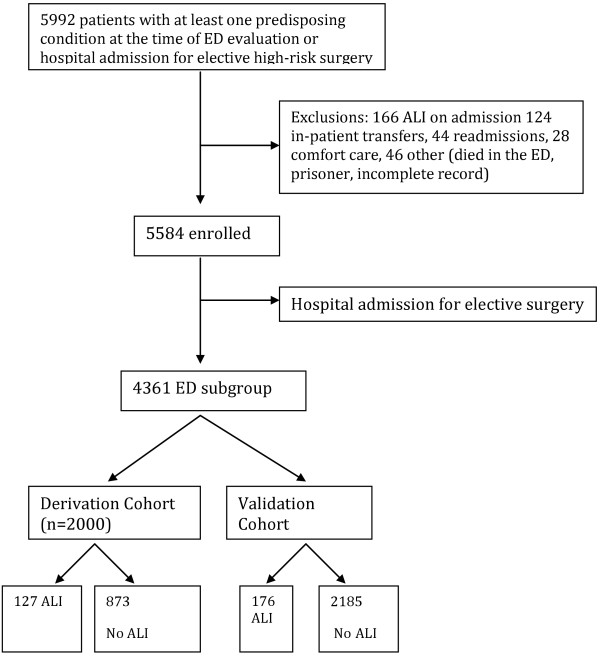
Study schematic.